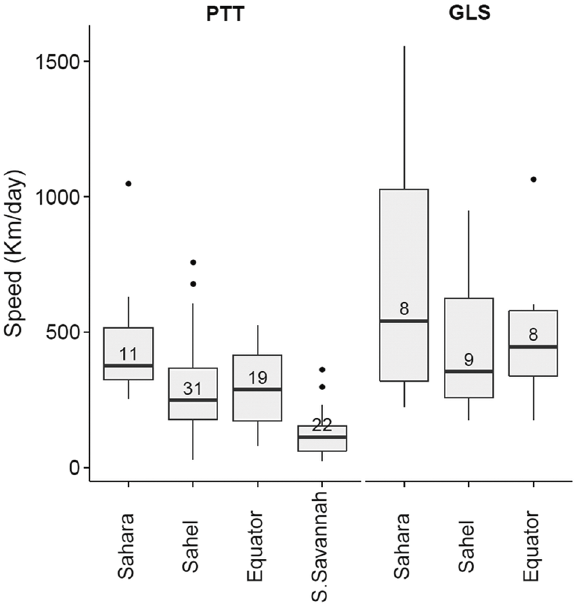
Fig. 3. Migration speed of Rollers in relation to region. Box plot showing median levels of migration speed (km/day) in relation to crossed region, separated by tracking method: satellite transmitters (PTT) and geolocators (GLS). Boxes show interquartile ranges (IQR). Bars represent maximum and minimum values within 1.5 IQR. Dots represent outliers (outside 1.5 IQR). Numbers inside boxes represent sample size (number of steps between consecutive stops, given non-significance of the random factor bird identity ; see